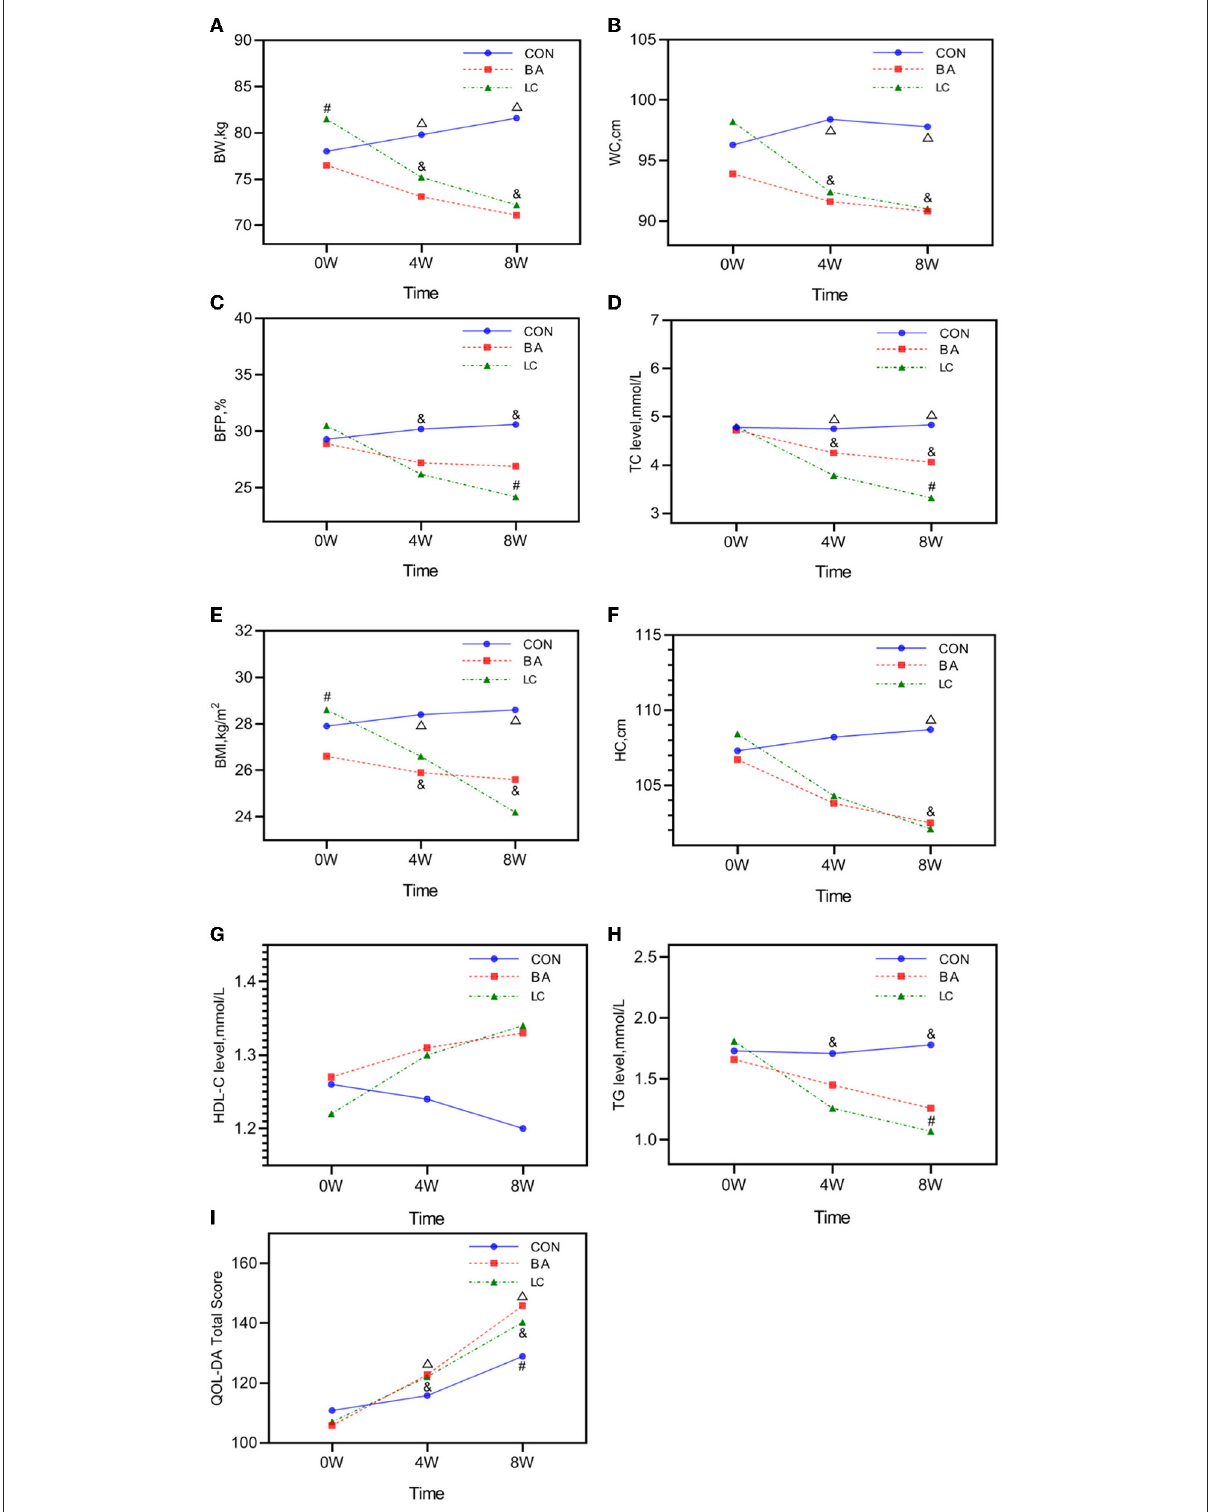
FIGURE2 Analysis of the time–group interaction in the generalized estimating equation (GEE) models. (A) Time–group effect in the GEE model of BW. (B) Time–group effect in the GEE model of WC. (C) Time–group effect in the GEE model of BFP. (D) Time–group effect in the GEE model of